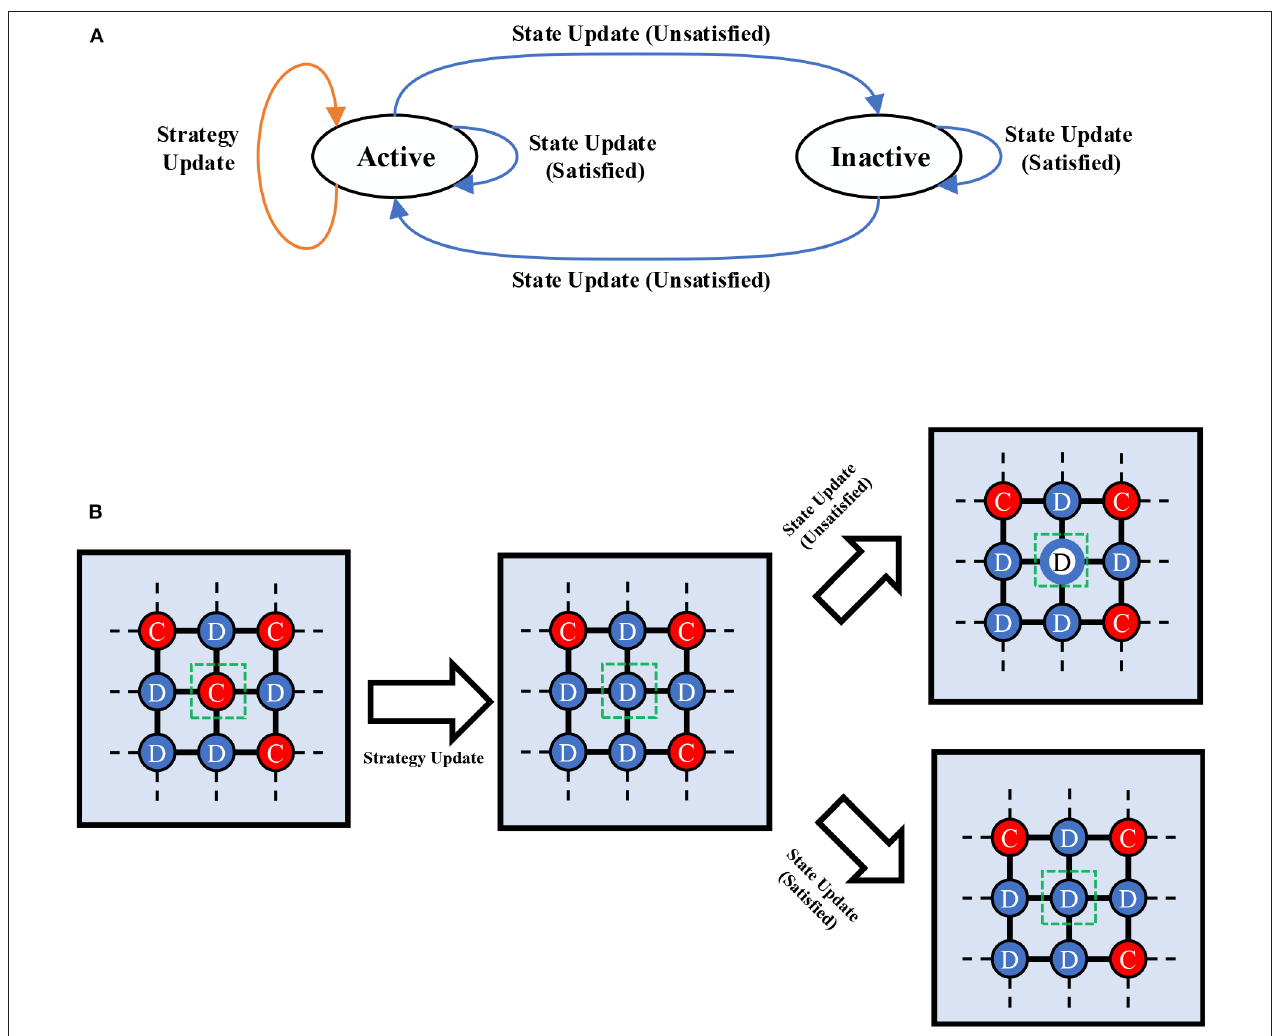
FIGURE 1 | (A) The diagram of state transition. Active nodes can imitate and reproduce, whereas inactive nodes cannot. During imitation process, players will compare its current payoff with the environment. If satisfied, it will stay in its current state, otherwise it will change to another state. (B) The diagram of simulation procedure. Suppose the node with green box decides to change its strategy (here, it will choose defection in the next round) through imitation process. After that, it decides to update its state. If satisfied, it stays in active state, otherwise it become inactive. In the next step, this inactive node does not play the game with its opponent and the imitation process cannot